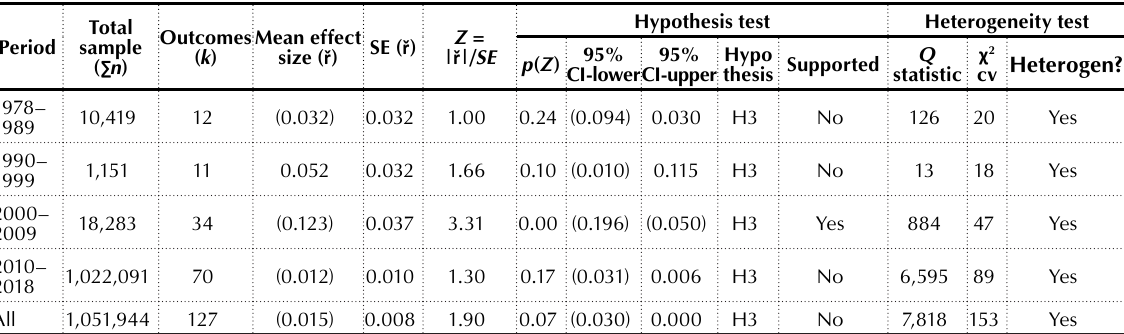
Table 7. Hypothesis testing – meta-analysis – penalty